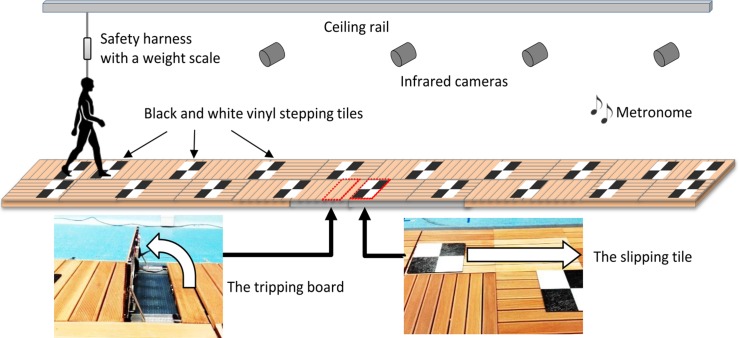
The trip and slip perturbation system used for this study.A slip was induced by a movable tile on two hidden low-friction rails with linear bearings that could be unlocked to slide up to 70cm upon foot contact. A trip was induced using a 14cm height tripping board that could be triggered to spring up from the walkway. The tripping board and slipping tile were not visually detectable and could be moved to any location along the walkway. Black and white vinyl stepping tiles were placed on the walkway to reproduce individual’s step length and a metronome was set to the individual’s cadence.